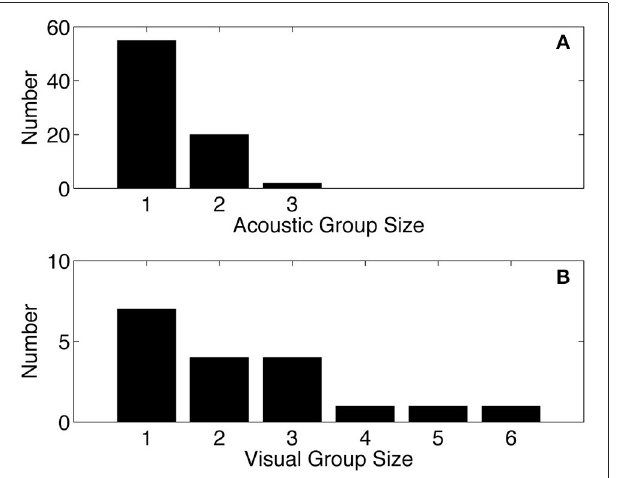
FIGURE 6 | Acoustic group size for Kogia spp. from site MC (A) , compared to group size from visual surveys in the GOM (B) based on data collected between 2003 and 2014 as part of SEFSC-NMFS sighting surveys (unpublished data). Mean of acoustic group size = 1.31, median = 1, N = 77. Mean of visual group size = 1.58, median = 1, N = 52.